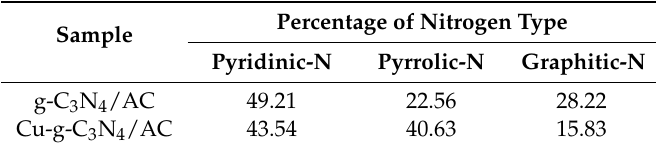
Figure 5. X-ray Photoelectron Spectroscopy (XPS) spectra of Cu-g-C 3 N 4 /AC and g-C 3 N 4 /AC: ( a ) Wide XPS spectrum; ( b ) XPS deconvolution of N 1s . Violet and Black: original data line; Red and Purple: fitting curve; Dark Yellow and Magenta: the characteristic peak of the pyridinic-N; Navy and Royal: the characteristic peak of the pyrrolic-N; Olive and Dark Cyan: the characteristic peak of the graphitic-N; Blue and Wine: original data. Table 2. Relative contents and binding energies of nitrogen species of the catalysts.